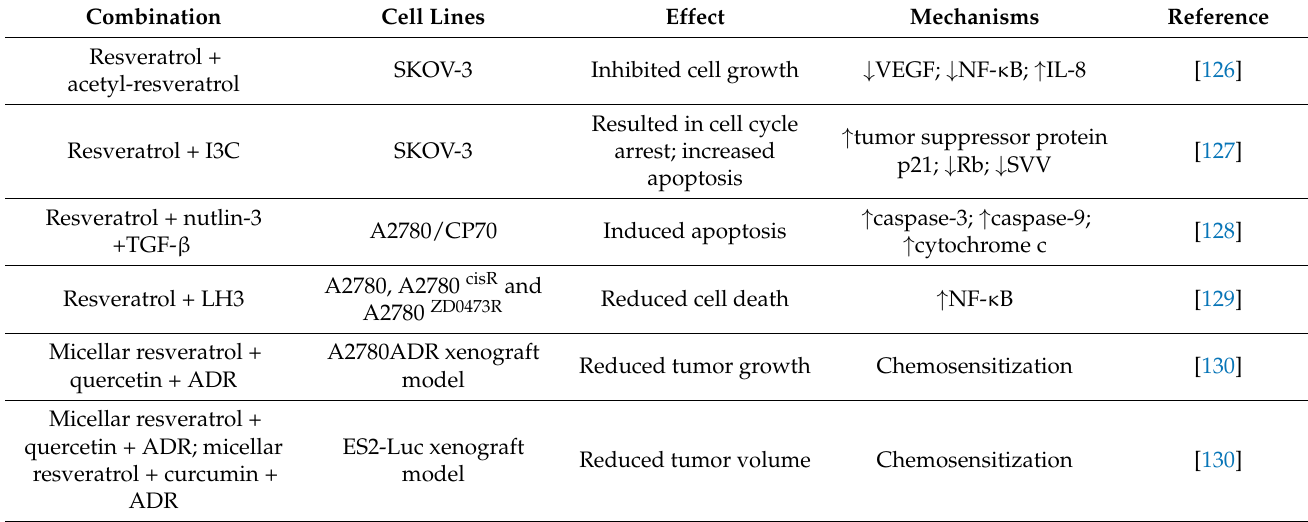
Table 4. Effects of resveratrol in combination with other